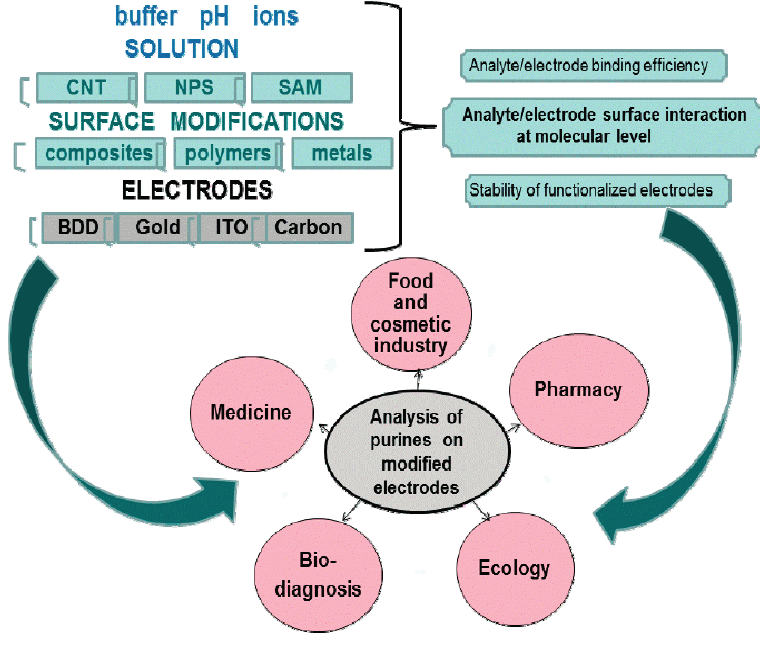
Figure 7. Application of electrochemical sensing of purine nucleobases and their